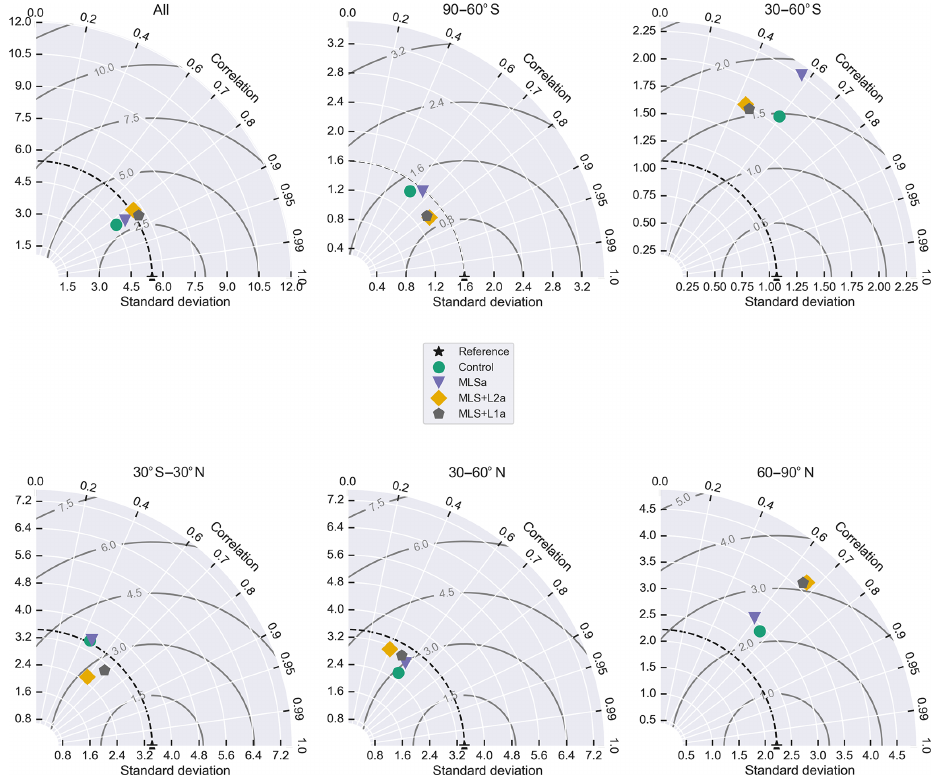
Figure 13. Taylor diagrams of modelled tropospheric ozone columns (340–750hPa) for the Control simulation (green), MLSa (violet), MLS + L1a (grey) and MLS + L2a (yellow) averaged globally and for five separate latitude bands. The Taylor statistics are computed against